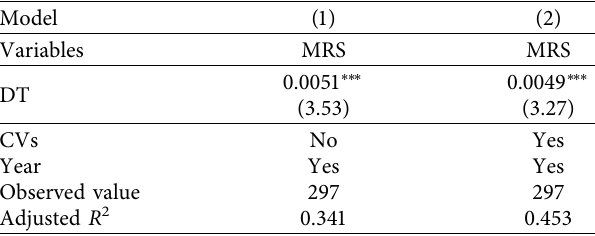
Table 4: Digital transformation and performance of listed companies.